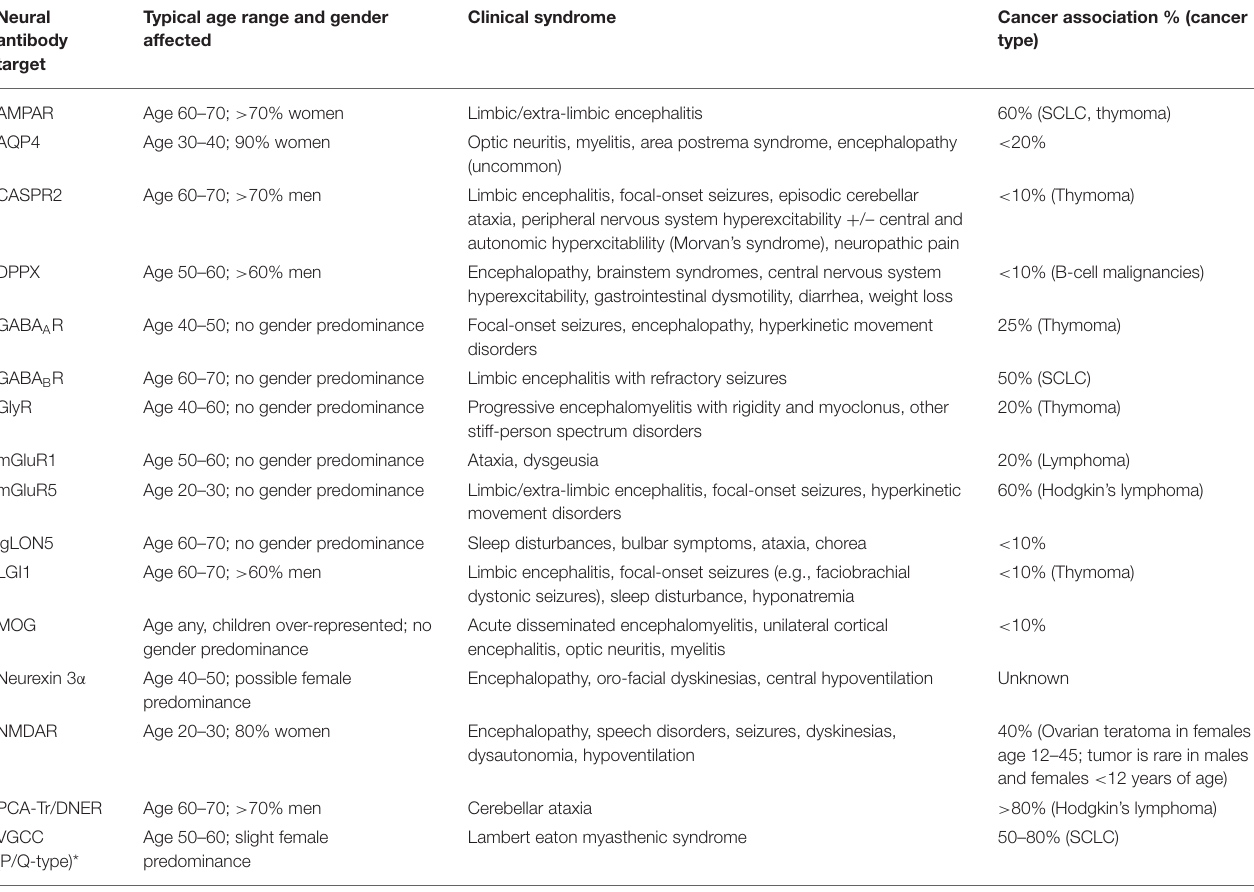
TABLE 2 | Demographic, clinical, and oncologic associations for neural autoantibodies targeting extracellular cell-surface/synaptic antigens. Neural